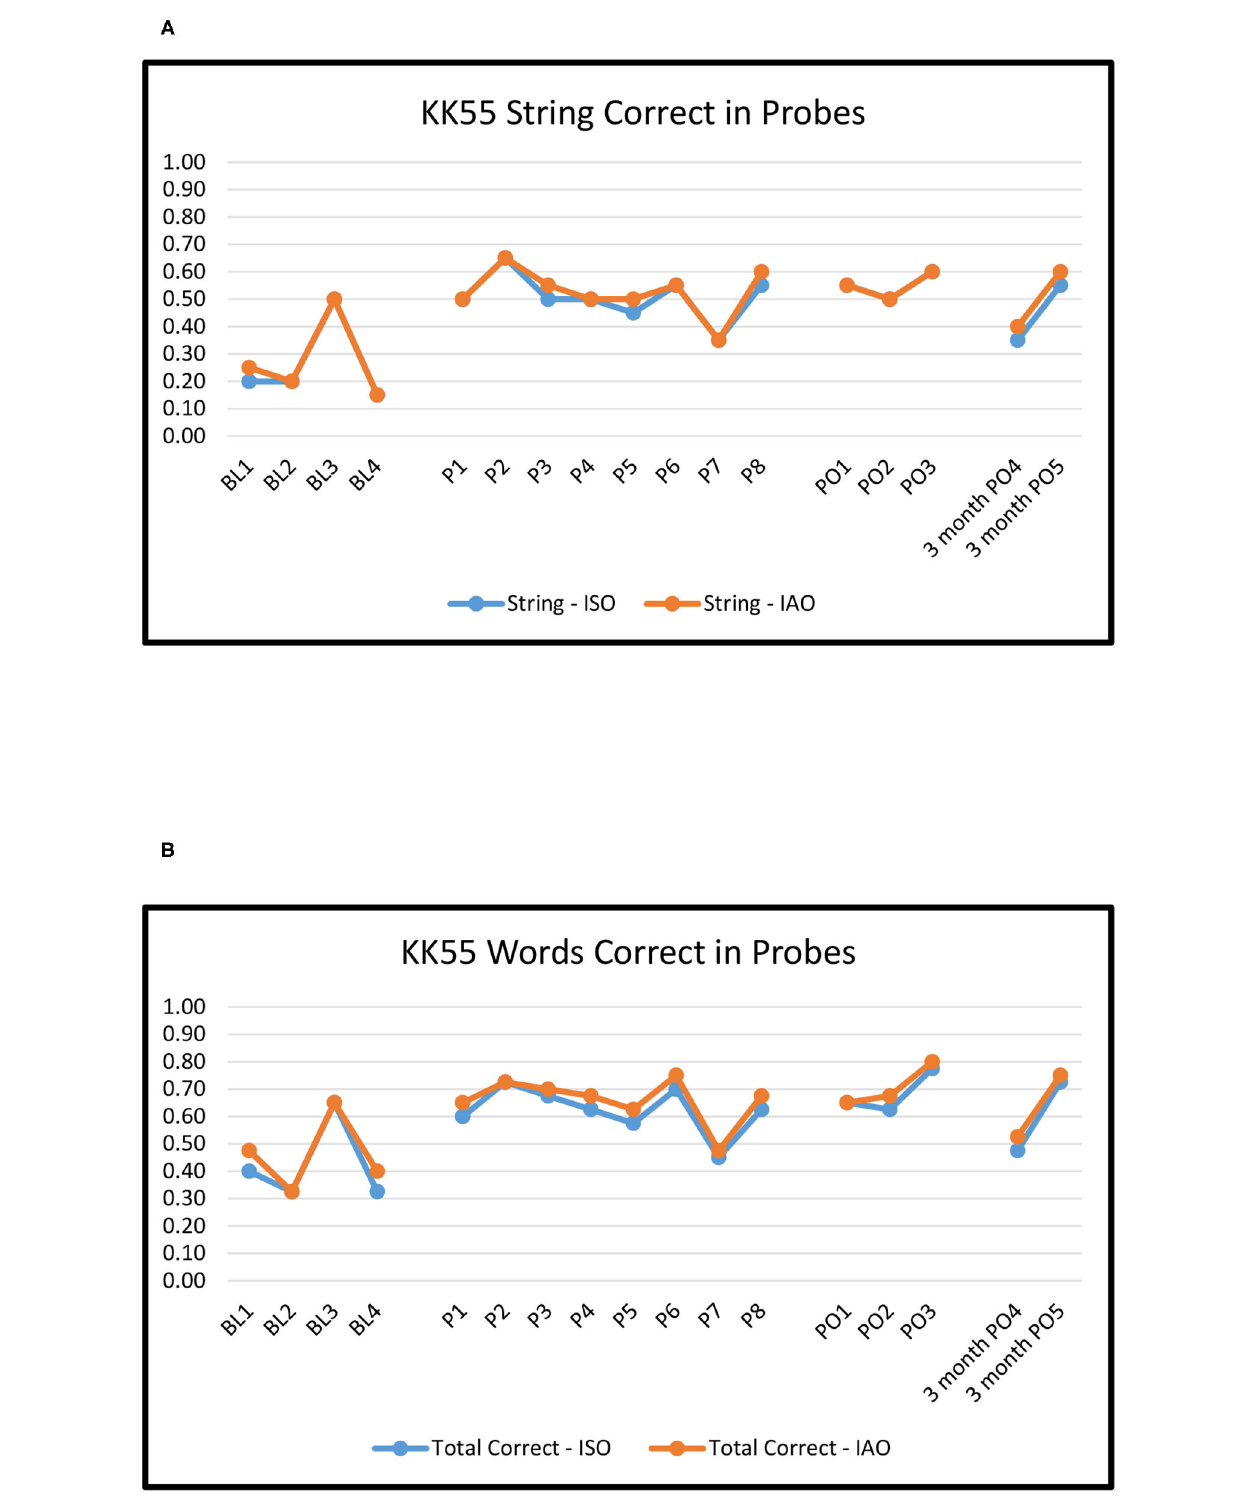
FIGURE 5 | KK55: Proportion of word strings (A) and words (B) correct in baseline, treatment, post-treatment, and 3 months follow-up probes.